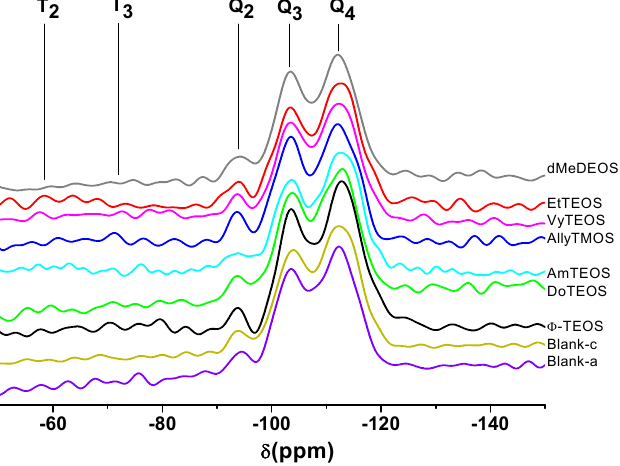
T( p- COOH)PP species 2 of OSA. f